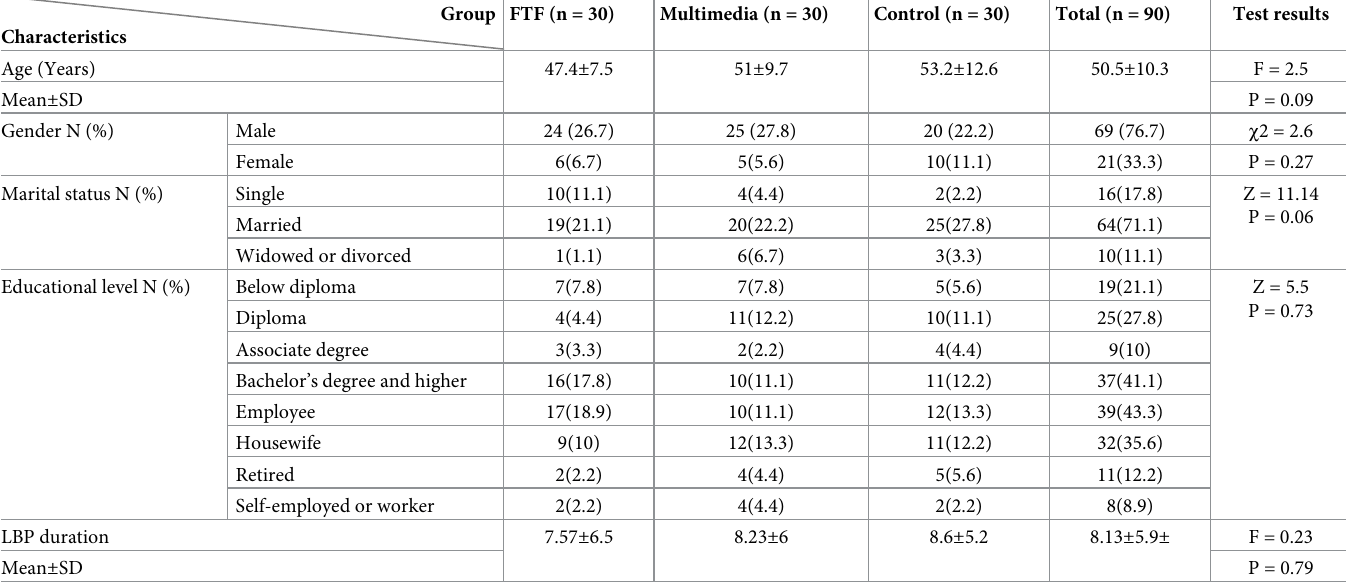
Table 1. Comparison of the study groups respecting participants’ demographic characteristics and LBP